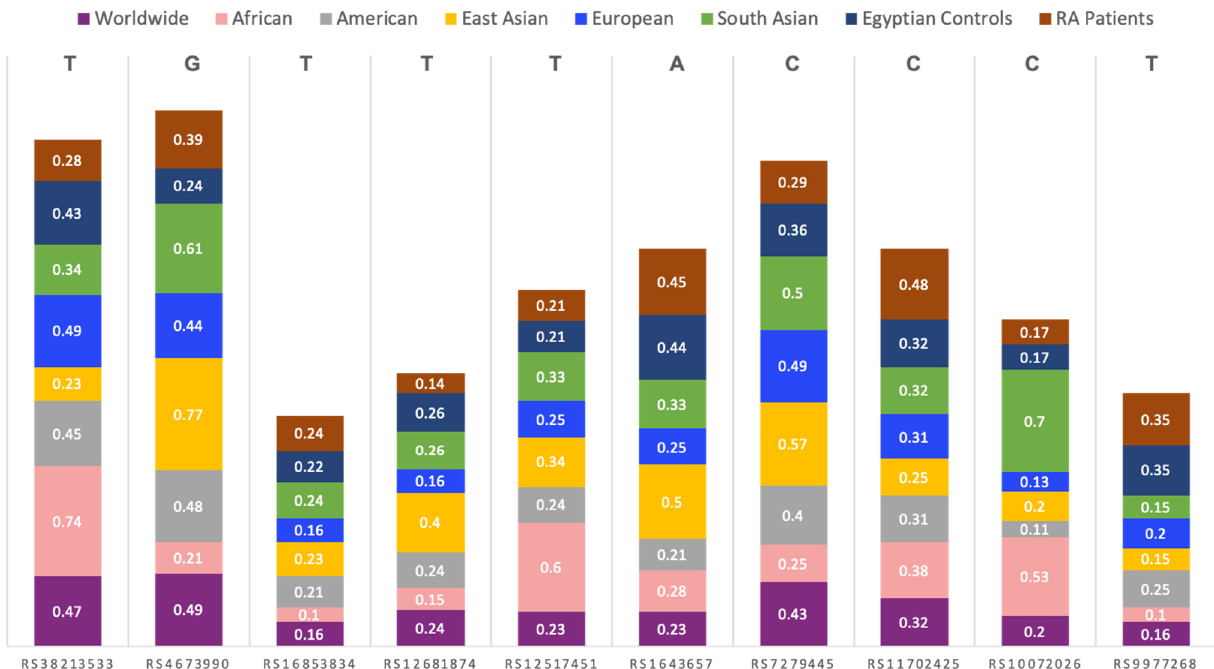
Figure 3. Comparison between the study groups’ minor allele frequencies and those of other ethnic populations from 1000 Genome Project (https://www.ensembl.org/) accessed on 20 January 2022.